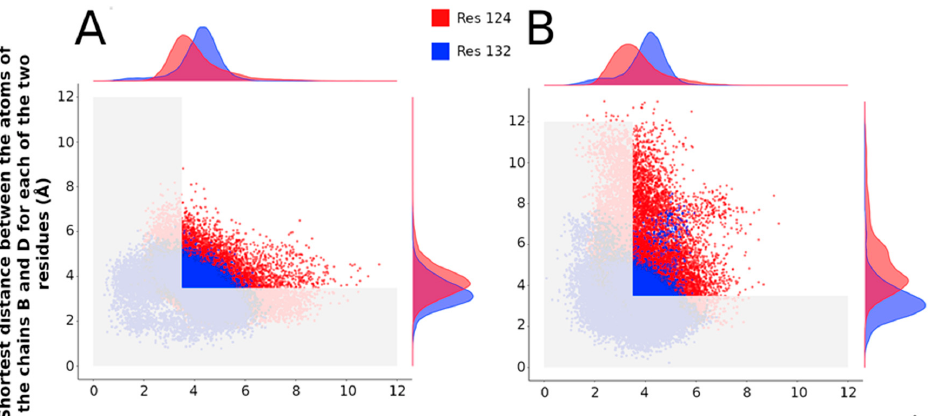
Figure 7. Gating at the two constriction points L124 and Y132. ( A , B ) Scatter plots of distances between C α atoms of the residues 124 (in red) and 132 (in blue) for chains AC and BD. ( A ): For KirBac3.1 WT ( B ): For KirBac3.1 W46R.